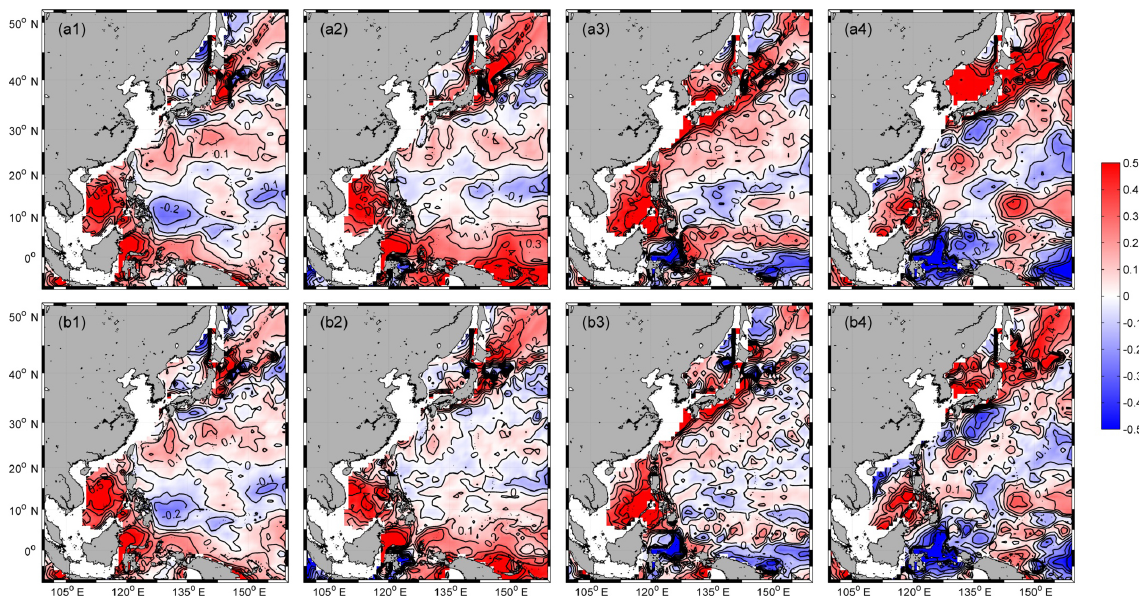
Figure 10. Monthly mean salinity bias at surface (in 1): (1) January, (2) April, (3) July and (4) October: (a) SSS error calculated by SF and